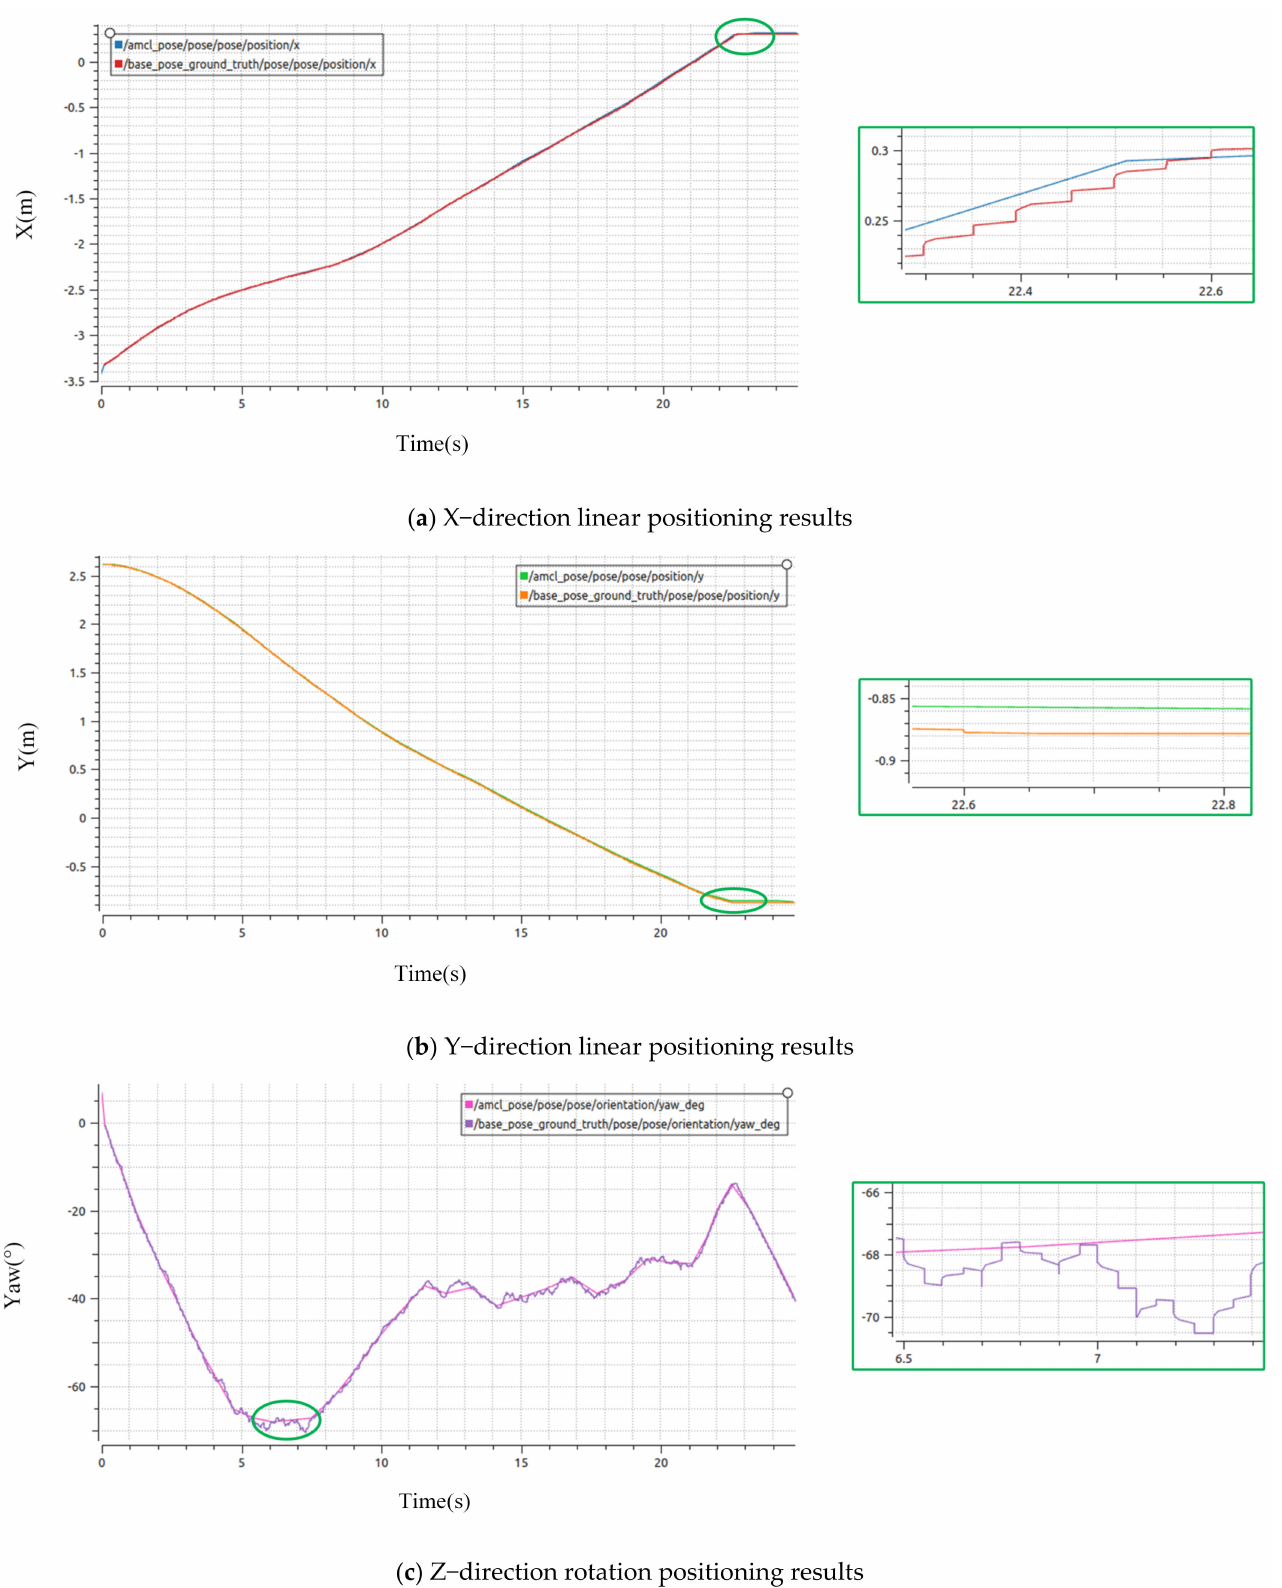
Figure 10. Results of the second group of improved AMCL simulation positioning